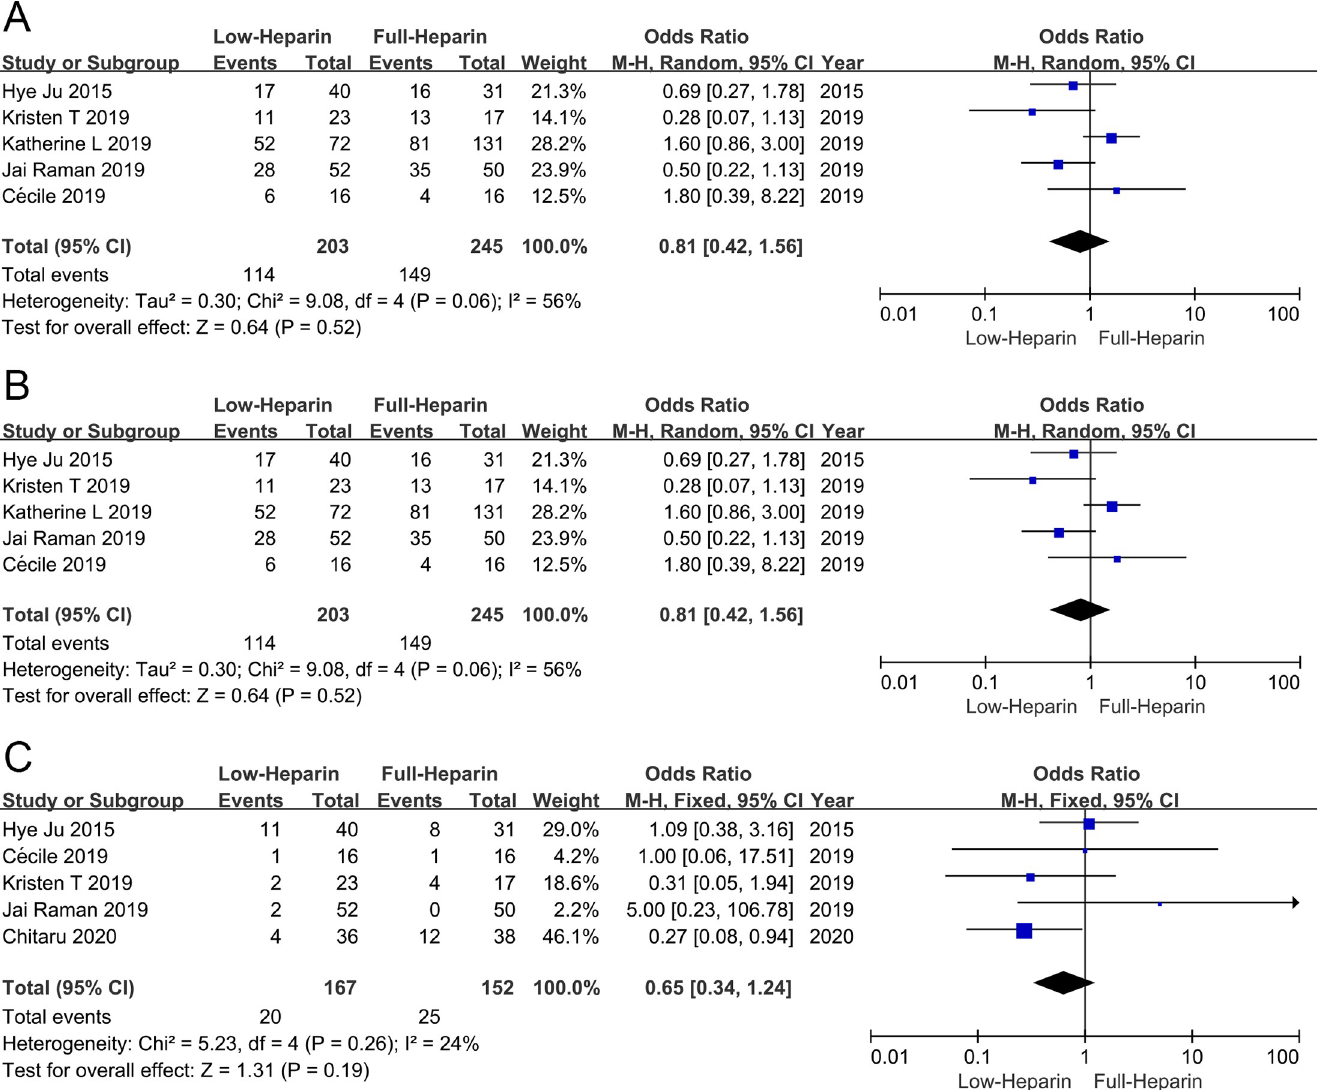
Fig 5. Forest plots of meta-analysis in hospital mortality (A), successfully weaned off ECMO (B) and oxygenator exchange (C). ECMO = extracorporeal membrane oxygenation.